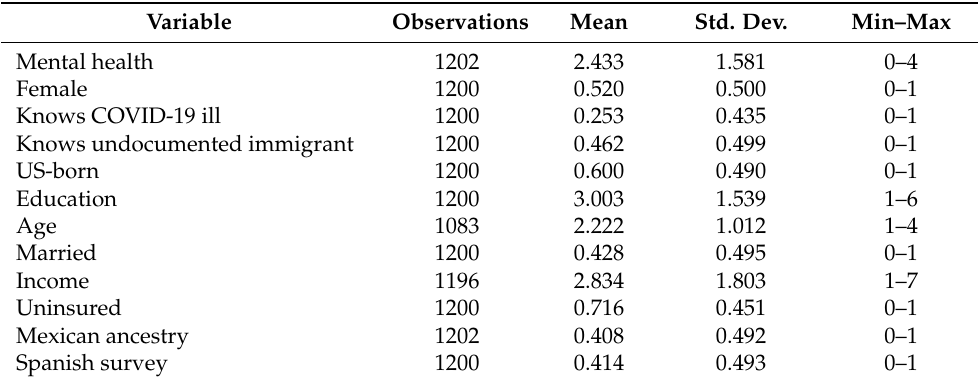
Table 1. Summary statistics of the variables used in this study. Variable